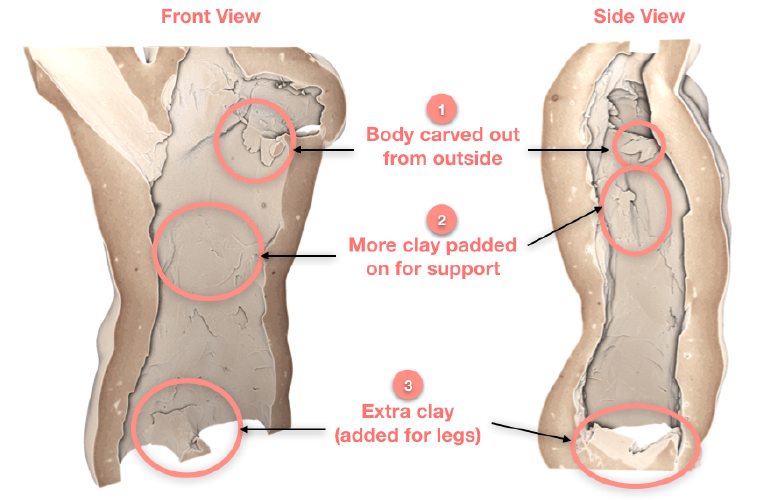
Figure 6. Marked locations highlight the techniques used to shape the hollow terracotta